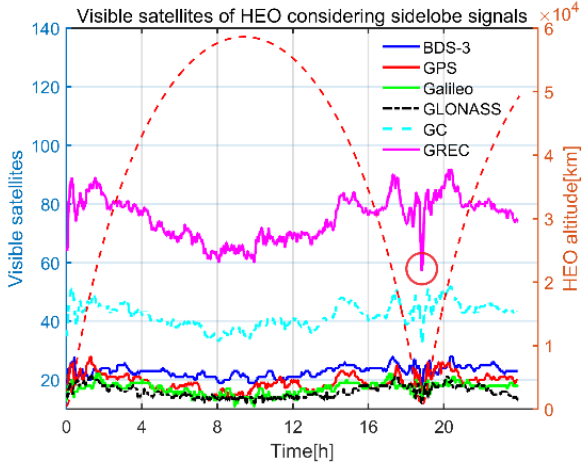
Figure 10. GDOP of GEO spacecraft.